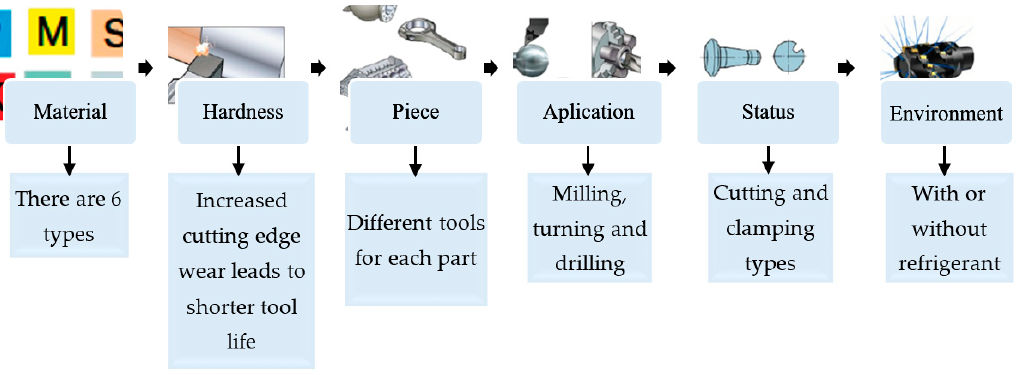
Figure 13. Parameters involved in machining according to ISO 513 ,